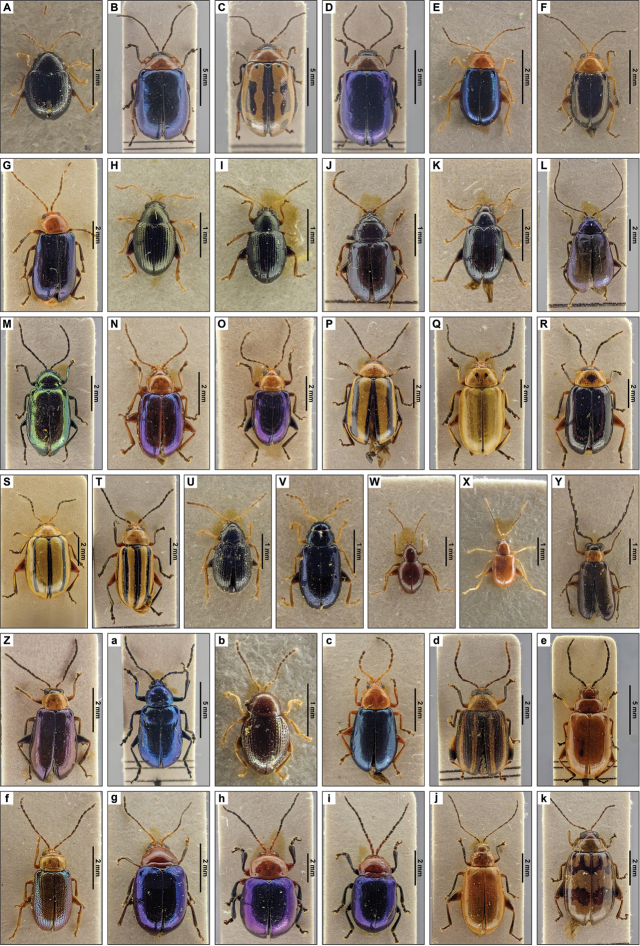
Dorsal pictures of the species of Galerucinae – Alticini from El Salvador currently present in the collections of the RBINS. Pictures of nomina nuda spec.s are not depicted. AAcallepitrixestebaniaBAlagoasaacutangulaCA.bipunctataDA.ceracollisEAyalaiaminorFA.salvadorensisGCacoscelisguazapaHChaetocnemafulvicornisIC.mexicanaJChalatenanganyaquadrifidaKCyrsylusrecticollisLDeuteralticalongicornisMDiphalticatrifiniensisNDiphaulacacordobaeOD.wagneriPDisonychabrevilineataQD.figurataRD.nigritaSD.ovataTD.recticollisUEpitrixhirtulaVGenaphthonatransversicollisWLongitarsusberryiXL.varicornisYLupraeafulvicollisZL.portilloiaMacrohalticasalvadorensisbOreinoderaapteracPhrynocephalaevicollisdPhysimerusfemoralisePlatiprosopusacutangulusfPlectotetrasurquiagSyphreabalneriahS.pretiosaiS.quintanillaijSystenavariabiliskWalterianellavenustula. High resolution images can be found at http://collections.naturalsciences.be/ssh-entomology.